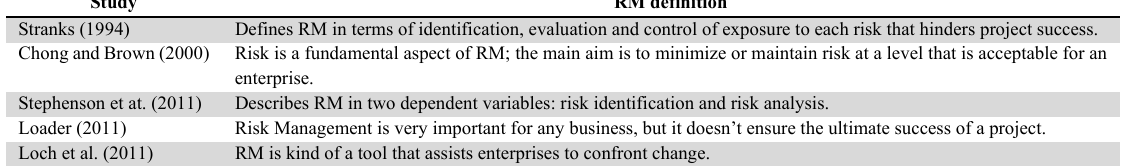
Perspective of RM by different